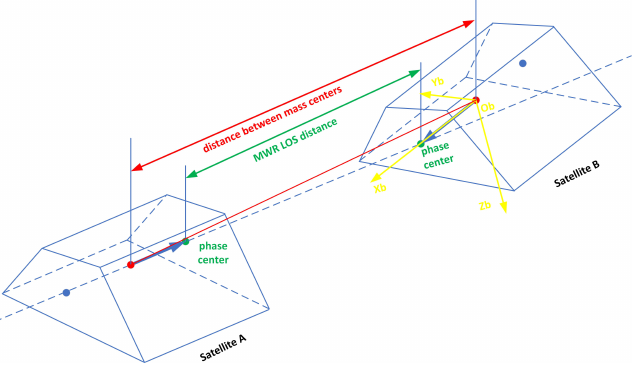
Figure 2. The geometry of LOS distance between leader-follower satellite antenna centers and distance between mass centers (real